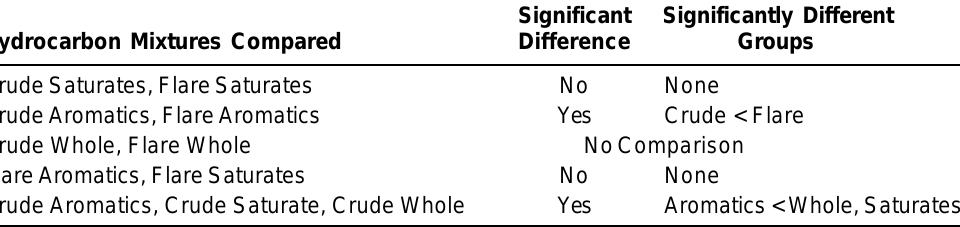
LBB ANOVA Comparisons Significant Significantly Different Hydrocarbon Mixtures Compared